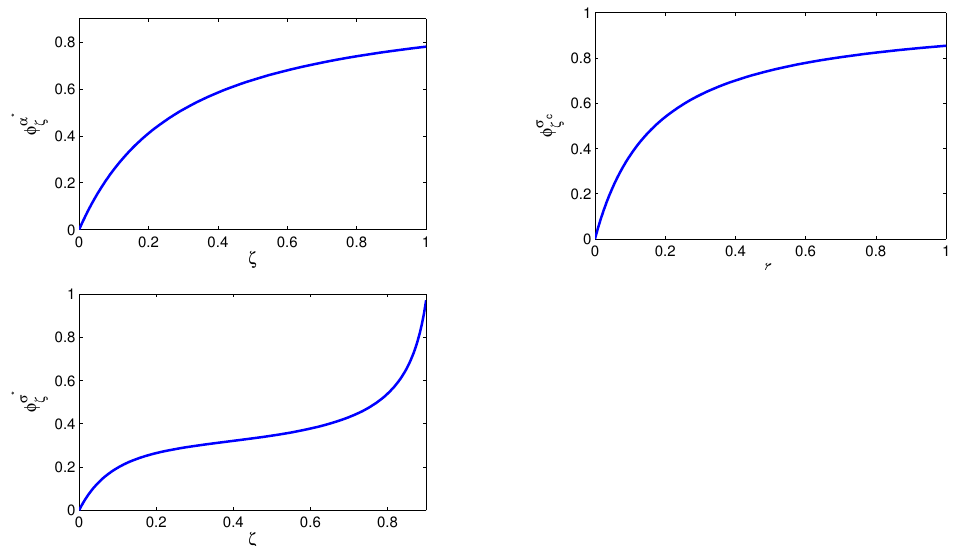
Figure 4. Sensitivity indices of the different thresholds α ∗ , σ c and σ SN as function of the information variable ζ . The other parameters are chosen as in Figure 1. ( Top-left ) Plot of the sensitivity φ α ∗ versus ζ the information variable ζ ; ( Top-right ) Plot of the sensitivity φ σ c versus the information variable ζ ; ζ ( Bottom ) Plot of the sensitivity φ σ SN versus the information variable ζ ζ